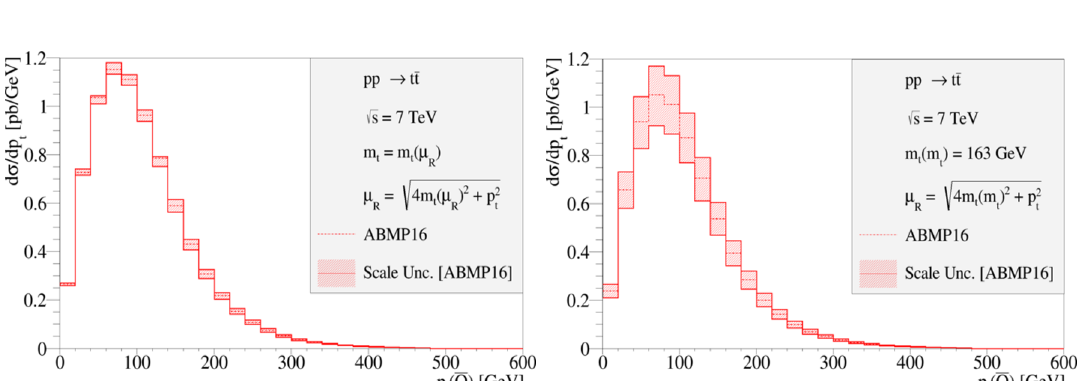
Figure 15 . The NLO differential cross-sections at the LHC ( bottom (intermediate panels) and top (lower panels) hadro-production with their 7-point ( µ R , µ F ) scale uncertainties as a function of the p T of the produced antiquark with mass renormalized in the MS scheme, using for central predictions µ R = µ F = renormalization scales µ m . The panels on the left use a dynamical mass renormalization scale µ m = µ R , with these two scales varied simultaneously during µ R variation (procedure (i) for scale variation discussed in the text), whereas the panels on the right use the static mass renormalization scale µ m = m Q ( m Q ) , with m Q ( m Q ) fixed to the values of the PDG ( m c ( m c ) = 1.28 GeV, m b ( m b ) = 4.18 GeV, m t ( m t ) = 163 GeV). The α S ( M Z ) values, the α S evolution and the central PDFs extracted from the ABMP16 NLO fit are used in all parts of the